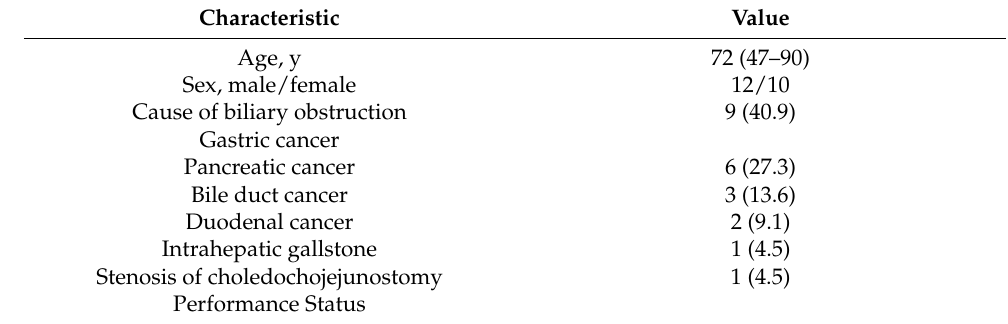
Table 1. Patient Table 1. Patient characteristics.